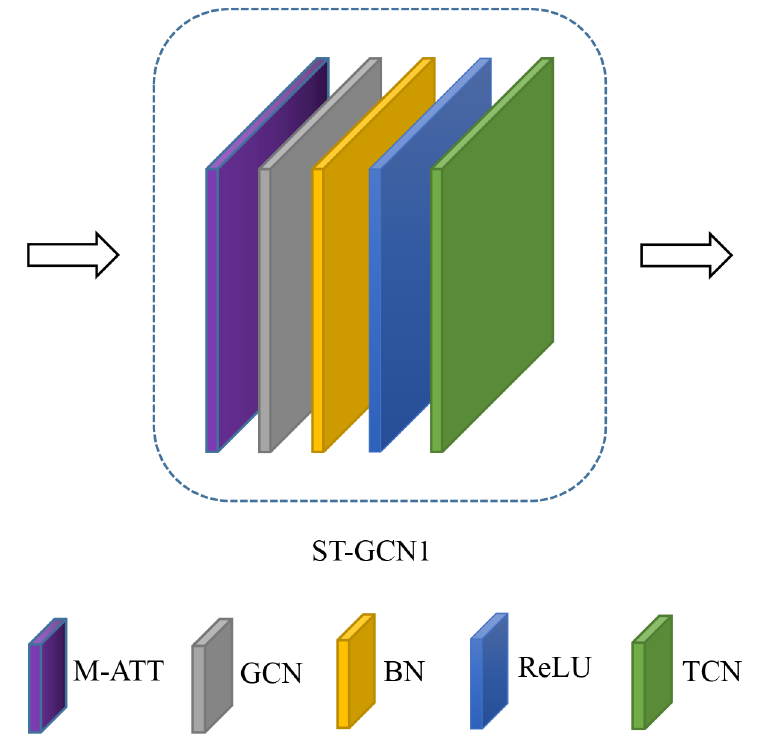
Figure 10. M-ATT in improved